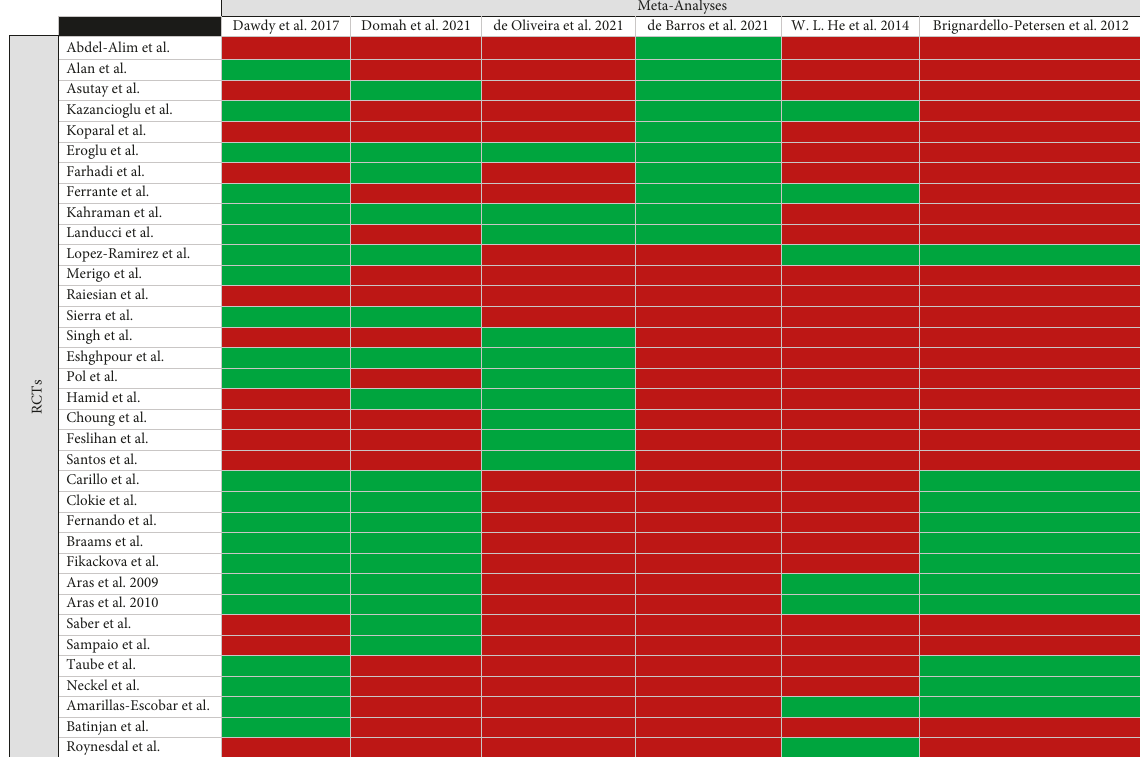
Figure 6: Citation matrix of meta-analyses evaluating the effectiveness of low-level laser therapy in reducing pain after third molar surgery (Green � included and Red � not